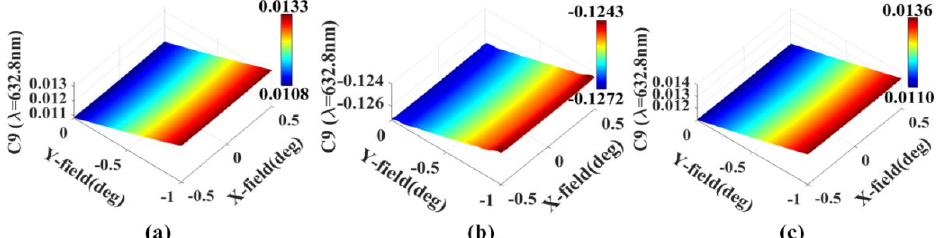
Figure 4. Distribution of Fringe Zernike spherical aberration (C9) in the full-field of the off-axis TMA telescope: ( a ) before perturbation, ( b ) after perturbation, and ( c ) after compensation correction.